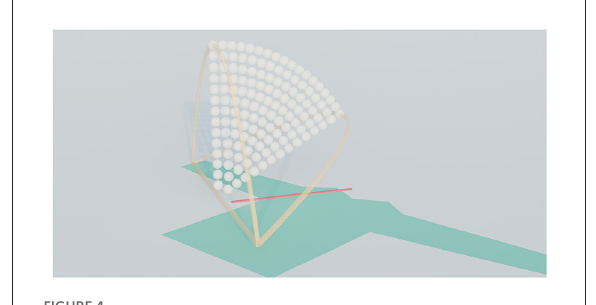
FIGURE4 Visualization of the trajectory search space. The white dots indicate the peaks of the